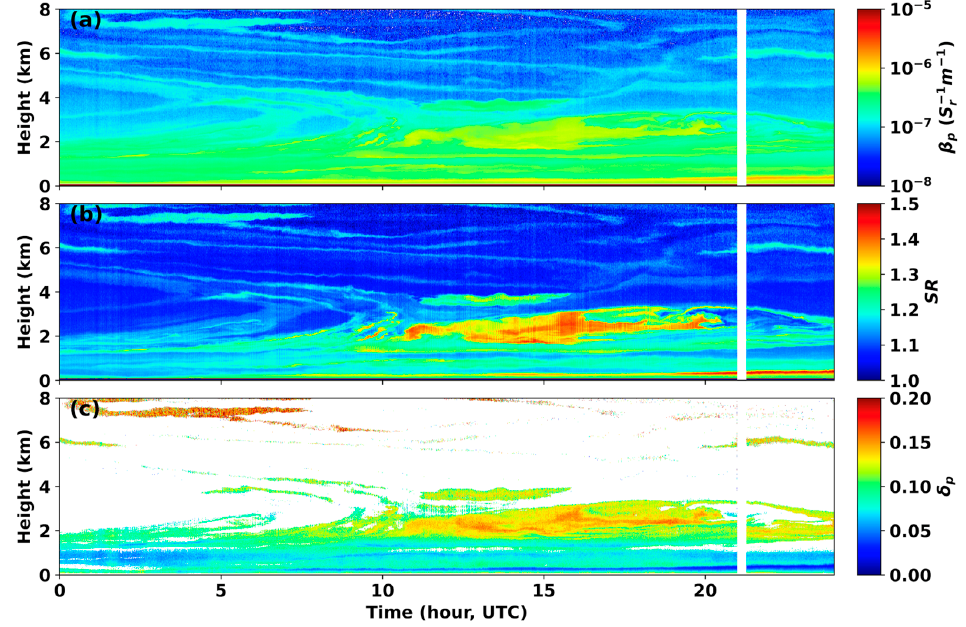
Figure 2. An example of HSRL measurements on 22 March 2016 at the NSA site. ( a ) time-height plot of HSRL particulate backscatter coefficient ( β p ); ( b ) scattering ratio ( SR ); ( c ) particulate linear depolarization ratio ( δ p